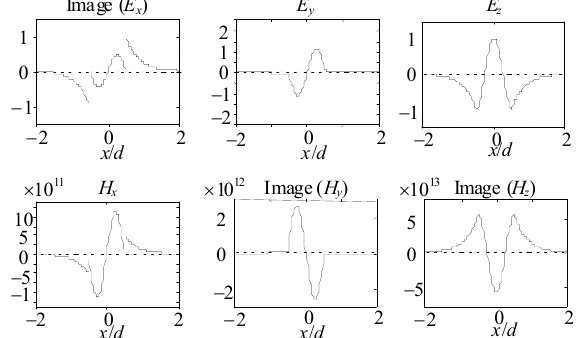
Fig. 9 Amplitudes of electromagnetic field components at 3 k d  for LCP even mode when m = 1. 0